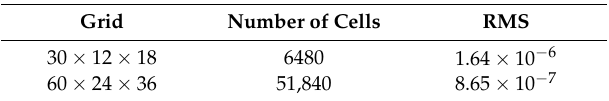
Table 2. The root mean square (RMS) error of the mass fraction on the coarse and medium grid with respect to the solution on the fine